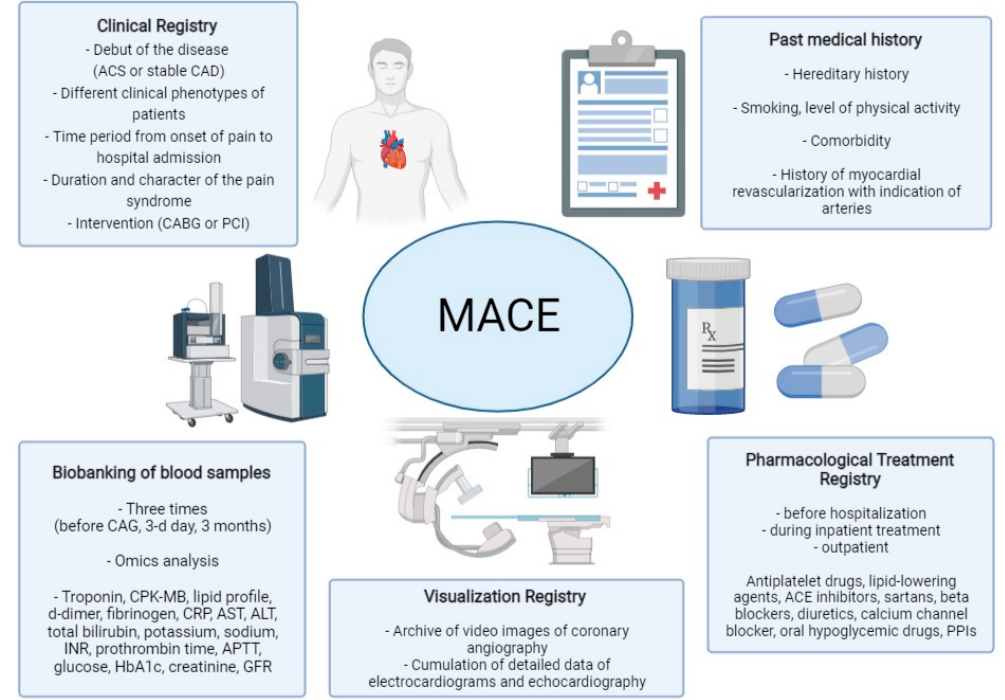
Figure 4. Characterization of the key parameters collected within the Registry. Design of the joint research project between University of Milan and the Almazov National Medical Research Centre. “ACS” = Acute Coronary Syndrome; “APTT” = activated partial thromboplastin time; “AST” = aspartate transaminase; “ALT” = alanine aminotransferase; “CABG” = coronary artery bypass graft; “CAD” = Coronary Artery Disease; “CPK-MB” = Creatine Phosphokinase-MB; “CAG” = Coronary Angiogram; “CRP” = C-Reactive Protein; “GFR” = Glomerular Filtration Rate; “HB1Ac” = Glycated hemoglobin; “INR” = International Normalized Ratio; “MACE” = Major Cardiovascular Event; “PCI” = Percutaneous Coronary Intervention; “PPIs” = Proton-pump inhibitors.